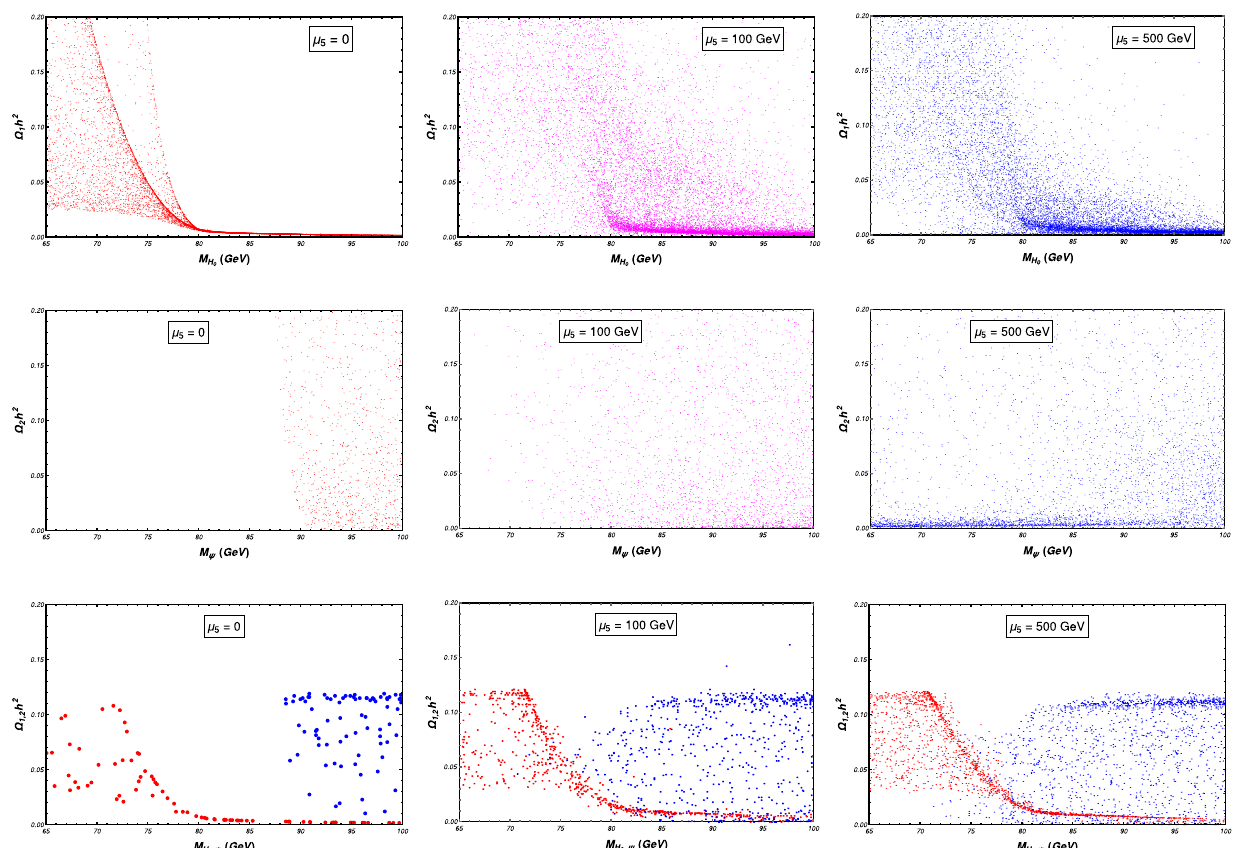
Fig. 9 In top row (cid:13) 1 h 2 as a function of M H (cid:13) 2 as a function of M ψ (GeV) for illustrative values of μ 2 h indicating the importance of the conversion channel ( ψψ → H 0 H 0 ). The total number of points generated are the same in all the cases. Third